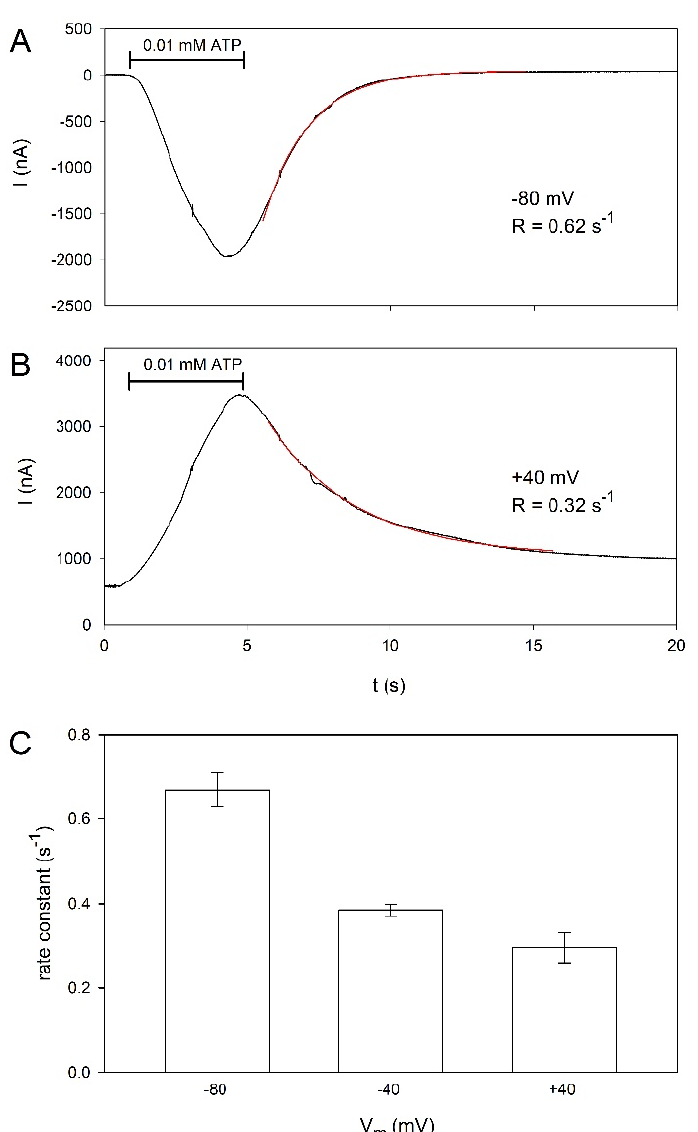
Figure 4. Voltage dependence of oocyte-expressed hP2X5 FL ion channels. Characteristic example of hP2X5 FL -dependent current evoked by 0.01 mM ATP for the time indicated by the horizontal bar at a membrane potential of −80 mV ( A ) or +40 mV ( B ), respectively. The exponential fits of the deactivation time courses according to eq. 3 are plotted as red lines, with the determined rate constants as indicated. ( C ) Statistics of the effect of the membrane potential on the deactivation rate constant. All mean values are significantly different from each other. Means are from 9–19 oocytes.